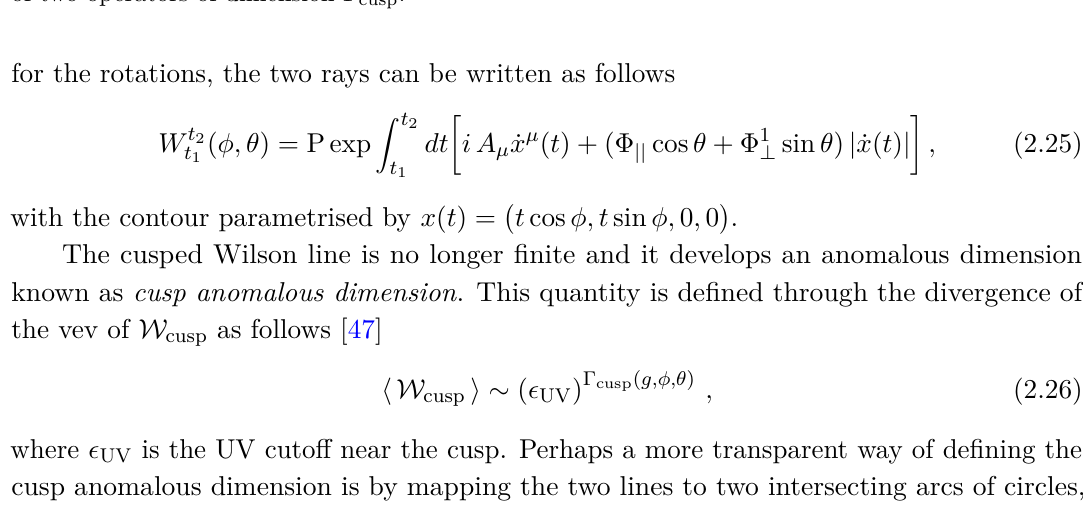
Figure 3 . Another conformally equivalent representation of the cusped WL. The expectation value of this object depends on the distance between the cusps in the standard way as a two point function of two operators of dimension Γ cusp